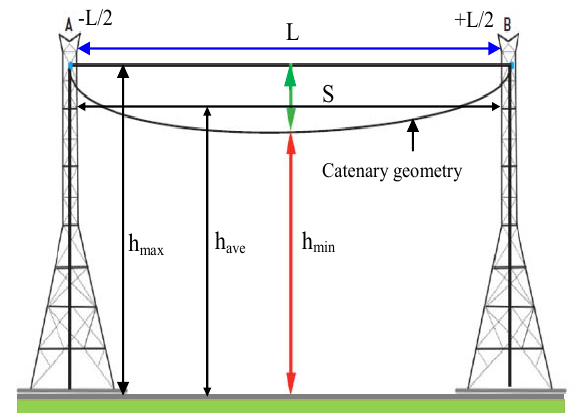
Figure 1: The basic catenary geometry for a single- conductor line.